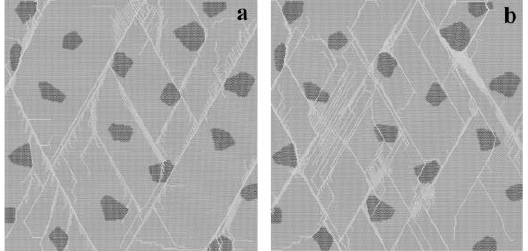
Fig. 2. Examples of fracture pattern of model water-saturated samples of concrete, characterized by different values of the analogue of the Darcy number: a) Da = 41.7; b) Da = 10000. Samples contain only capillary